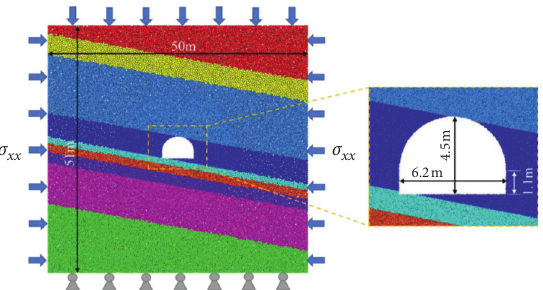
Figure 19: Numerical model for the surrounding rock of working face machine lane.